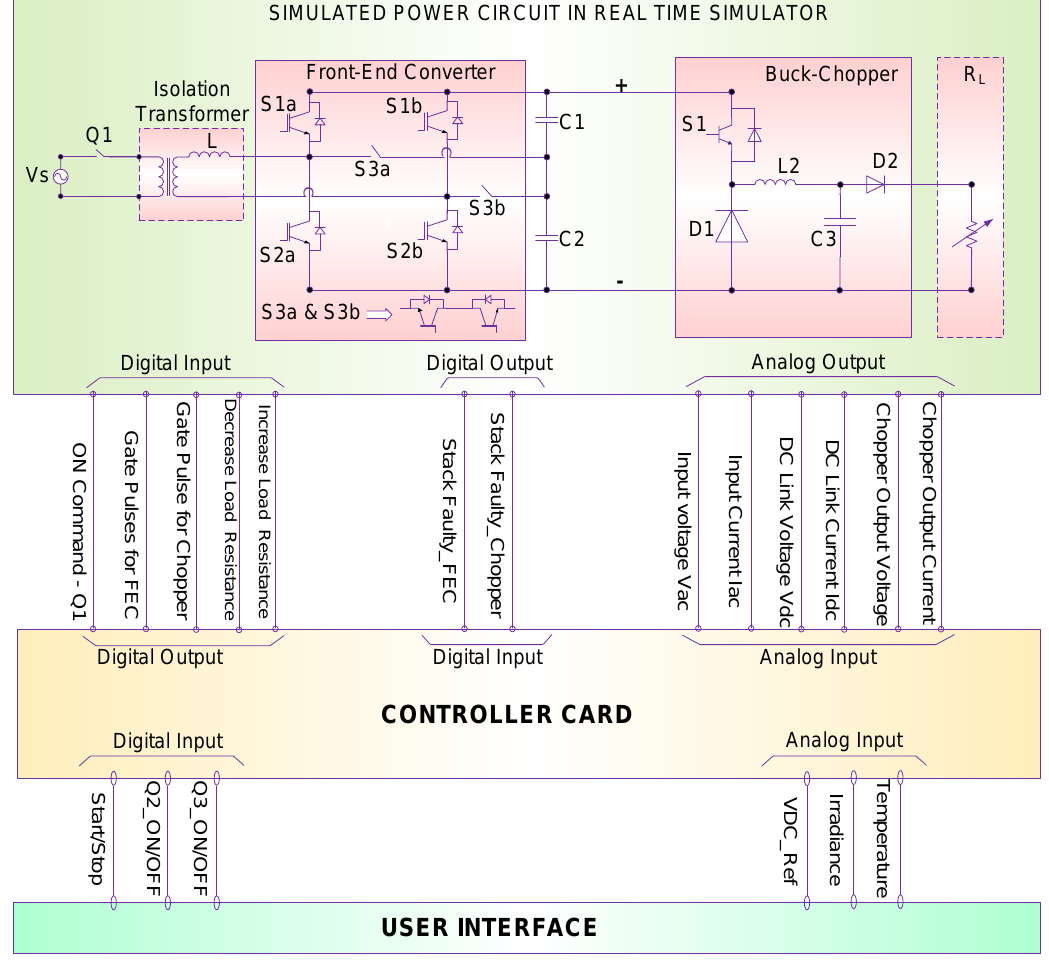
Figure 9. Controller-In-Loop Simulation setup for validation of proposed PV-Simulator Controls.